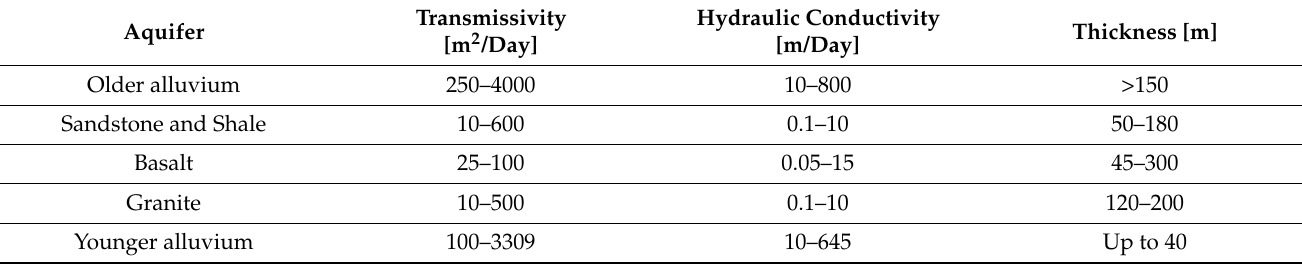
Table A2. Hydrogeological parameters of the aquifer systems in the study area (source: CGWB